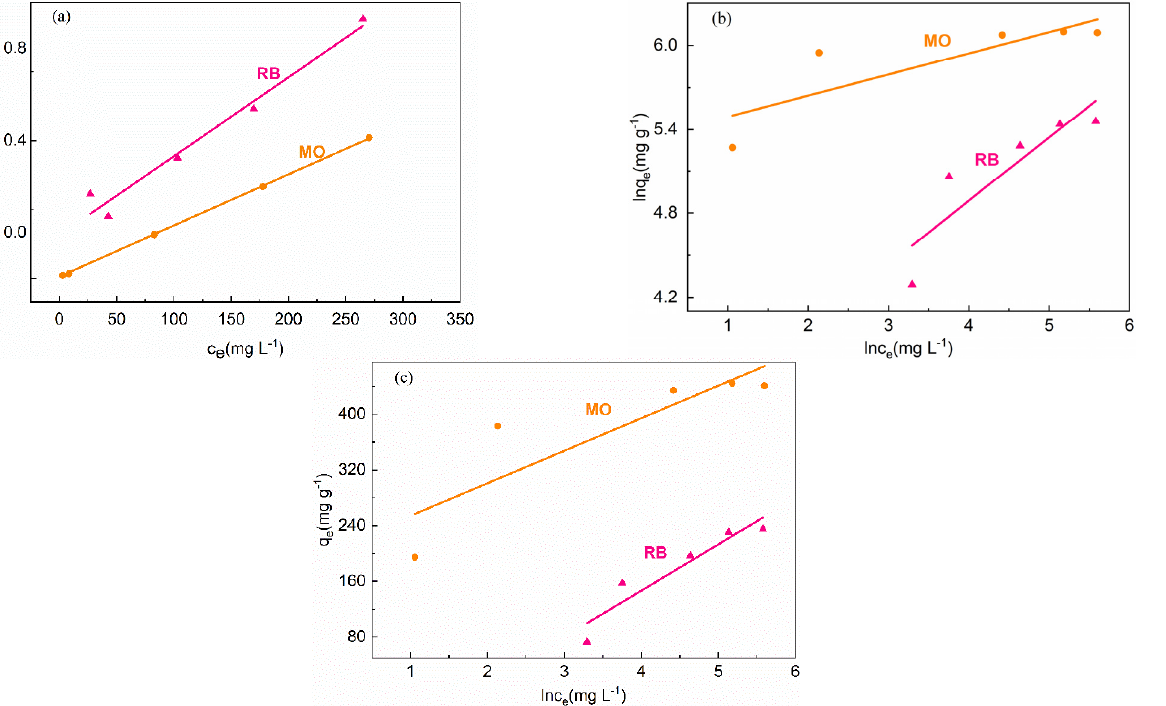
Figure 6. Experimental data for the adsorption of dyes on160-MIL-101 analyzed using ( a ) Langmuir, ( b ) Freundlich, and ( c ) Temkin models. ( b ) Freundlich, and ( c ) Temkin